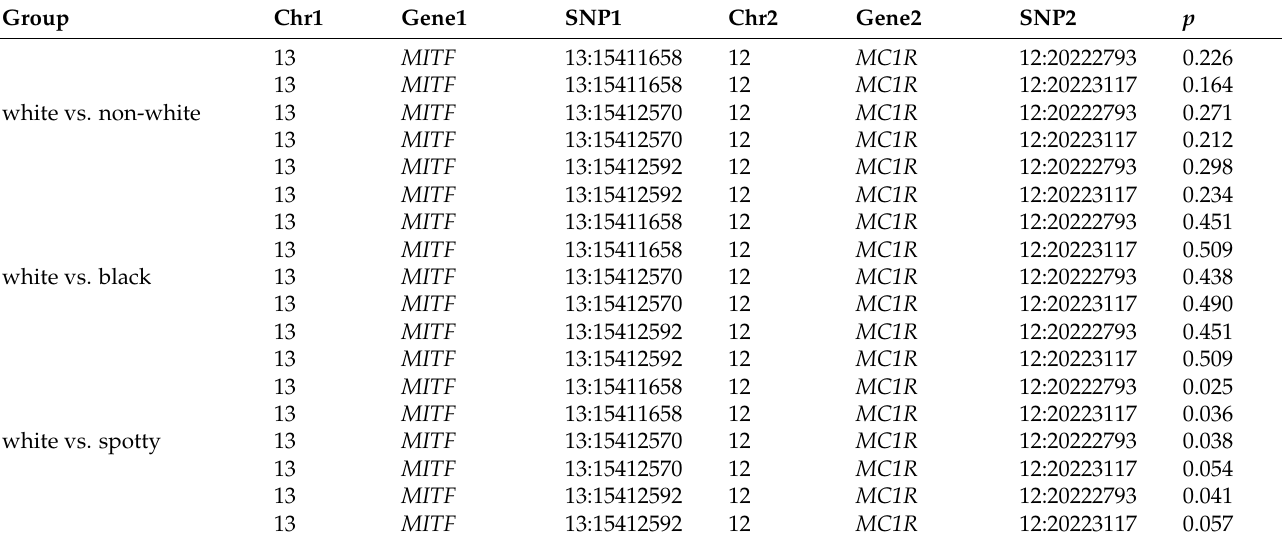
Table 3. Epistatic effects of MITF and MC1R